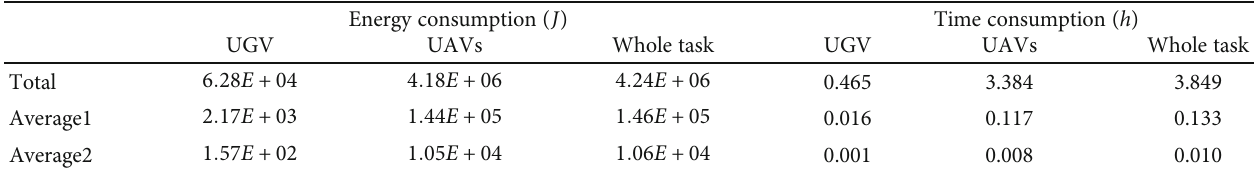
Figure 8: The initial positions of the target areas and the experimental results of the fi rst two stages: (a) the initial positions of these target areas; (b) the clustering and path planning results for the UGV. Table 2: The experimental results of a simple cooperative task.